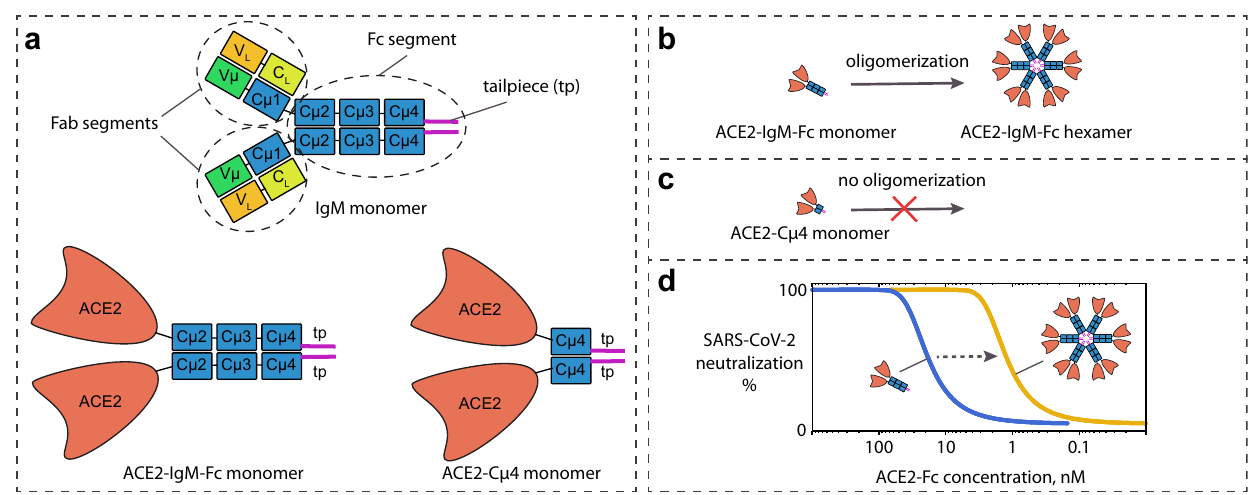
Fig. 5 Structure of the ACE2-IgM-Fc and ACE2-C µ 4 fusion proteins and their oligomerization properties. a Structures of a human IgM monomer composed of two Fab segments and an Fc segment including a tailpiece, and monomeric ACE2-IgM-Fc and ACE2-C µ 4 composed of two identical polypeptide chains linked by disul fi de bonds. b The ACE2-IgM-Fc monomer can oligomerize to form hexamers. c The ACE2-C µ 4 does not oligomerize. d The hexameric ACE2-IgM-Fc has more potent virus neutralization ef fi ciency compared to its monomeric counterpart. Table 2 Strategies to enhance the neutralization ef fi ciency of ACE2-Fc fusion proteins based on increased binding avidity. Engineering